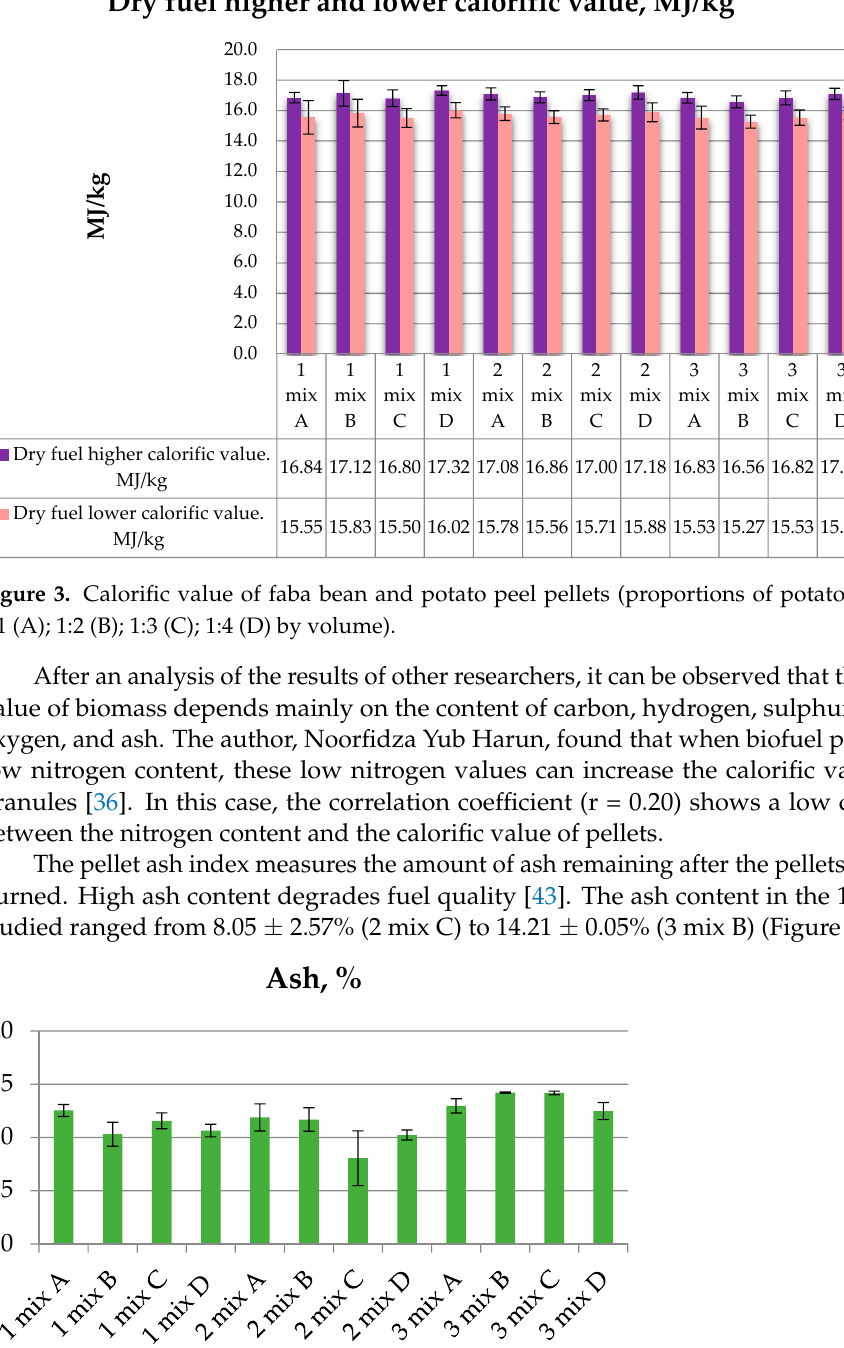
Figure 4. The ash content from the combustion of biofuel pellets (proportions of potato and beans: 1:1 (A); 1:2 (B); 1:3 (C); 1:4 (D) by